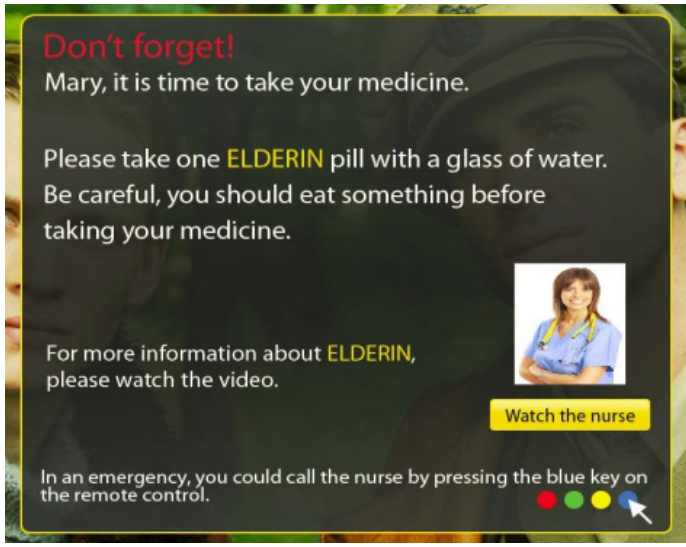
Figure 3. Reminder for taking a